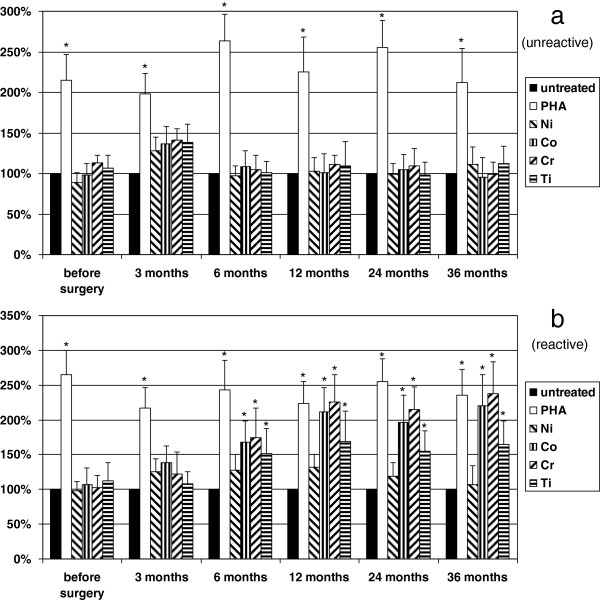
The effect of various metals and PHA on the proliferation rate of patients’ leukocytes. The effect of various metals (Ti 0.01 mM, Co 0.1 mM, Cr 0.1 mM, Ni 0.1 mM) and PHA (0.1 mg/ml) on the proliferation rate of patients’ leukocytes in group 3 is shown. Cells were untreated or treated as indicated. (a) (unreactive), it is clearly demonstrated that metal challenge did not influence cellular proliferation before and after the surgery. (b) (reactive), however, Co, Cr and Ti increased the proliferation rate significantly 6 months after surgery in 25% (10 patients) of group 3, which was increased up to 35% (14 patients) after 36 months, distinguishing a subgroup referred here as metal sensitive patients in group 3. Positive control PHA increased proliferation significantly in each experiment. Columns represent means + SD, level of significance is shown, *p < 0.05. Note that Ni did not influence proliferation significantly.